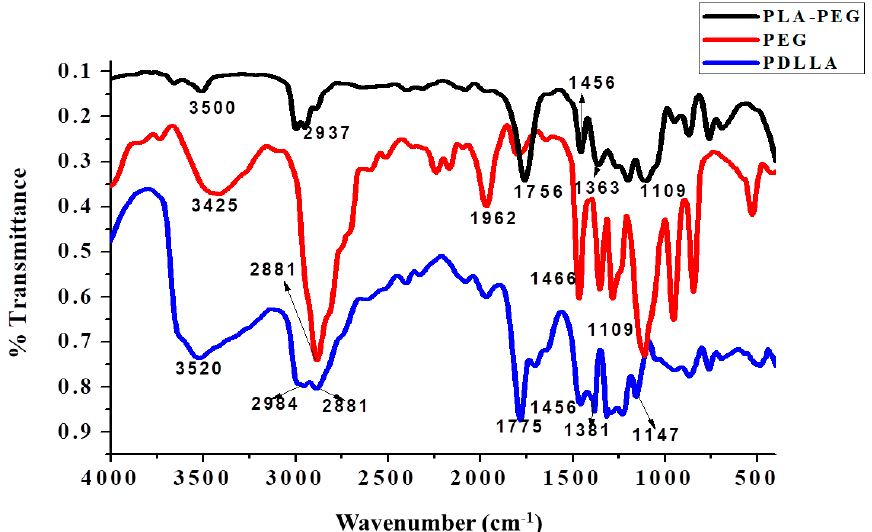
Figure 4. Overlay of the FTIR spectra of PLA-PEG (synthesized by transesterification), PDLLA, and PEG.